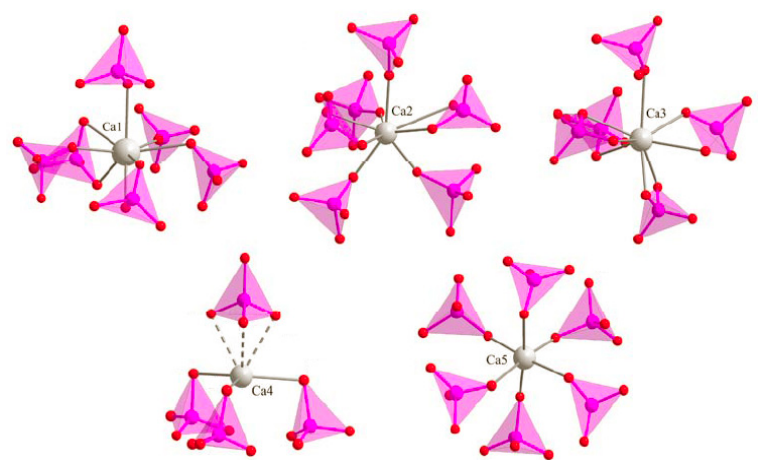
Figure 4. Local environment of the five calcium crystallographic sites in the β -TCP structure ( gray spheres represent the calcium atoms and pink tetrahedra represent the phosphate groups).